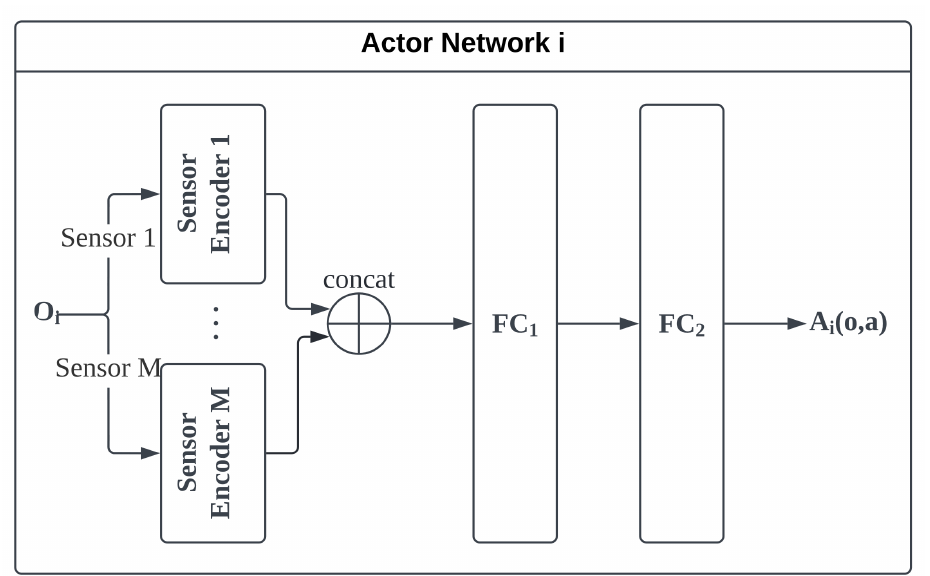
Figure 5. Actor network of F-MAAC